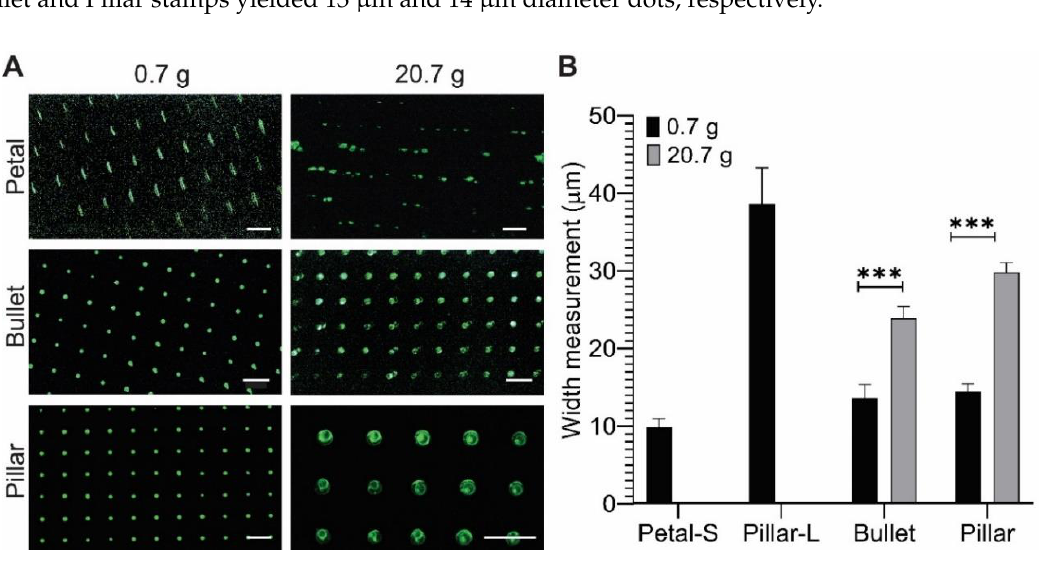
Figure 7. Microcontact Printing using MSAs. ( A ) Fluorescent microscopic images of the microcontact-printed PLL-FITC on a glass substrate. Two different weights were compared: 0.7 g (PDMS stamp only) and 20.7 g (plus 20 g weight). Petal did not hold the weight of 20.7g and yielded no proper transfer of protein. ( B ) Width of printed patterns. The additional weight significantly thickened the width of Pillar and Bullet printing by almost double. Error bars: STDEV. Statistical analysis: Student’s t -test (*** p < 0.001) . ( A ) Scale bar: 100 μm.